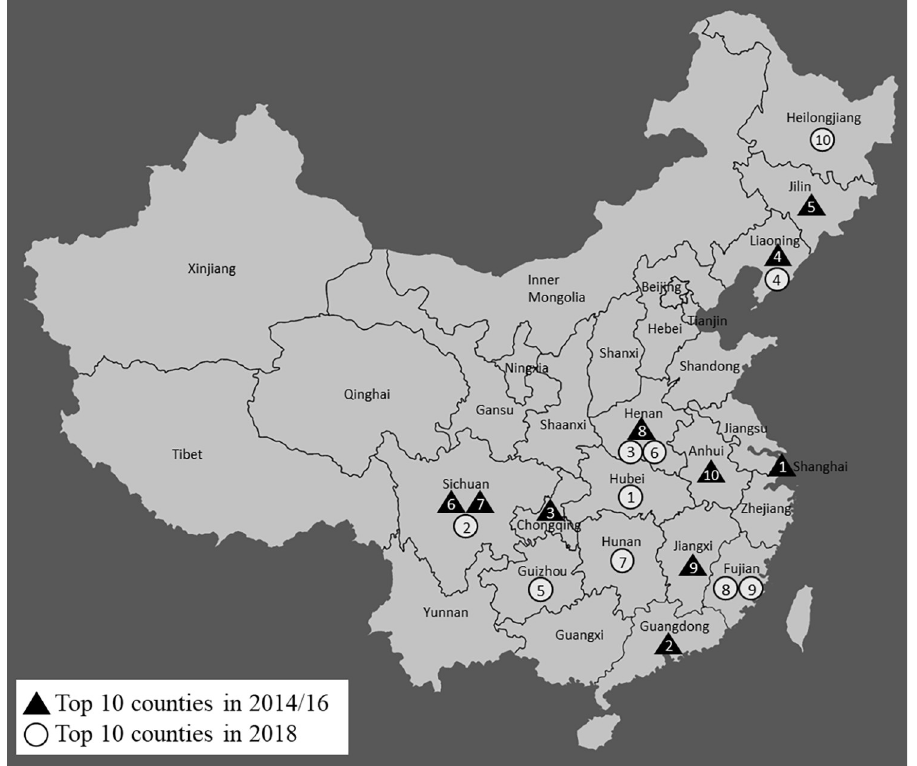
Fig 1. Places with the highest incidence of lung disease and hospitalization